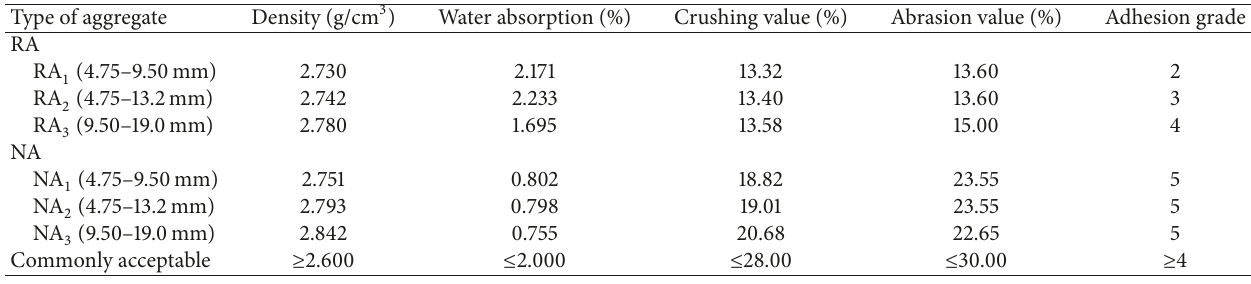
Table 1: Properties of RA and NA.